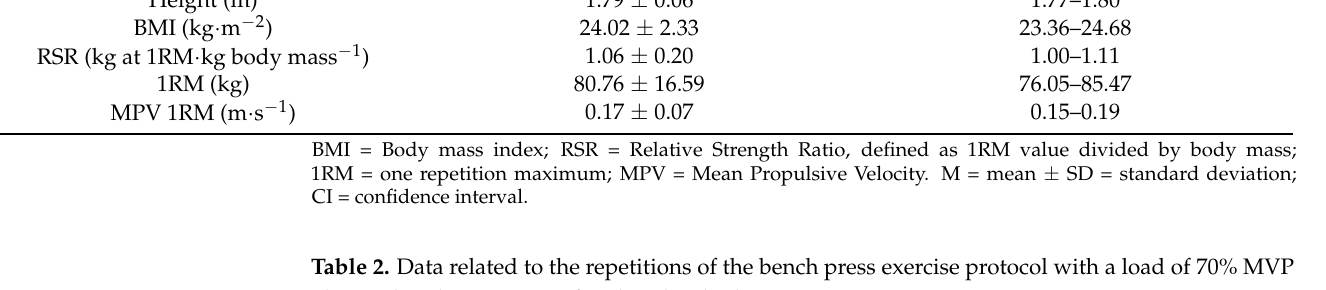
Table 2. Data related to the repetitions of the bench press exercise protocol with a load of 70%